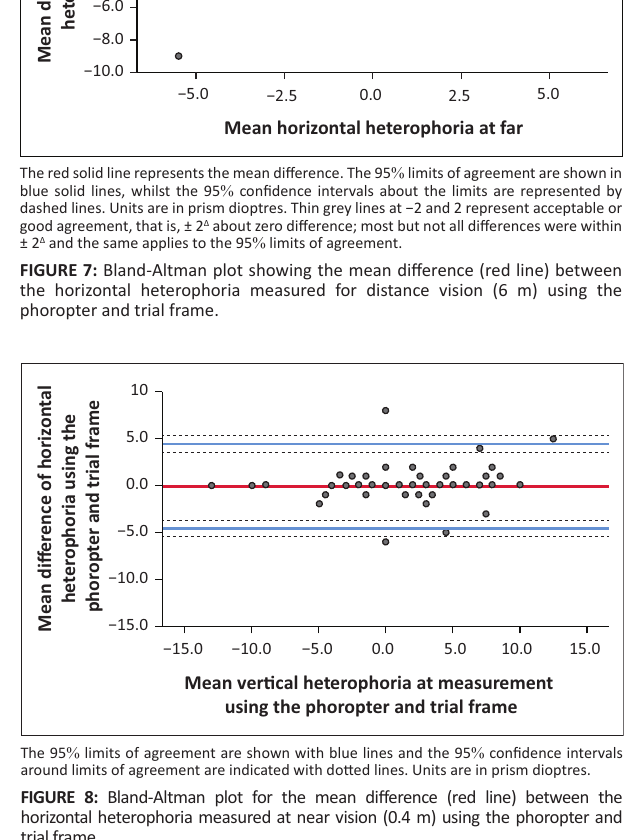
Mean ver(cid:9)cal heterophoria at measurement using the phoropter and trial frame The 95 % limits of agreement are shown with blue lines and the 95 % confidence intervals around limits of agreement are indicated with dotted lines. Units are in prism dioptres. FIGURE 8: Bland-Altman plot for the mean difference (red line) between the horizontal heterophoria measured at near vision (0.4 m) using the phoropter and trial frame. good reliability and values greater than 0.9 indicate excellent reliability (see Table 5).